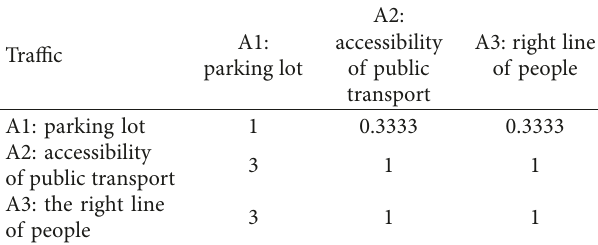
Table 3: Matrix of traffic criteria.